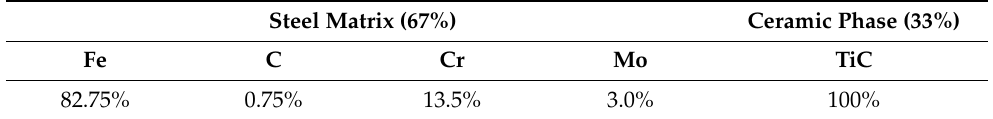
Table 3. Chemical composition of Ferrotitanit WFN in wt% [13].